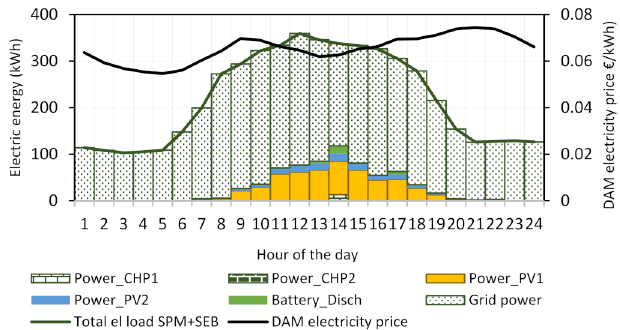
Figure 28. Electrical energy balance of the ILEC obtained with environmental optimization for the representative summer day.